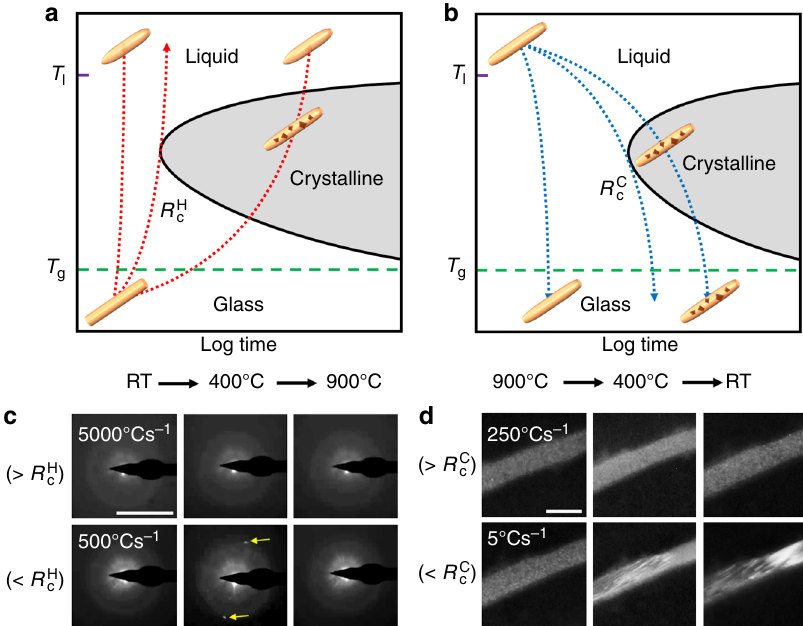
Fig. 1 Phase transition of metallic glass nanorods upon heating and cooling using in situ TEM. a , b Schematic time – temperature – transformation (T – T – T) diagram showing the correlation between crystallization and critical rate upon heating ( a ) and cooling ( b ). The lowest heating rate that bypasses the onset of crystallization nose from the glass state to the liquid is de fi ned as the critical heating rate ( R H ). In the same manner, the lowest cooling rate to skip c crystallization from above the liquidus temperature ( T l ) to the glass transition temperature ( T g ) is de fi ned as the critical cooling rate ( R C ). c , d In situ TEM c characterizations of a 40 nm nanorod using SAED mode for heating ( c ) and DF mode for cooling ( d ) process to identify the critical rates. The 40 nm nanorod was repeatedly heated and cooled with various rates to identify the critical rates. c The snapshots show a series of SAED images obtained from room temperature (RT) to 900 °C at a constant heating rate of 5000 °Cs − 1 (top row of c ), Supplementary Movie 1, and 500 °Cs − 1 (bottom row of c , Supplementary Movie 3), which are above and below the critical heating rate, respectively. The yellow arrows indicate the diffraction spots that re fl ect crystallization, which is only observed when the nanorod was heated below the critical rate. Scale bar is 5 nm − 1 . d The snapshots show a series of DF images taken from 900 °C to RT at a constant cooling rate of 250 °Cs − 1 (top row of d , Supplementary Movie 2) and 5 °Cs − 1 (bottom row of d ), Supplementary Movie 4, which are above and below the critical cooling rate, respectively. The crystallization is re fl ected in contrast changes in the DF images, which appear only at a slow cooling rate. Scale bar is 40